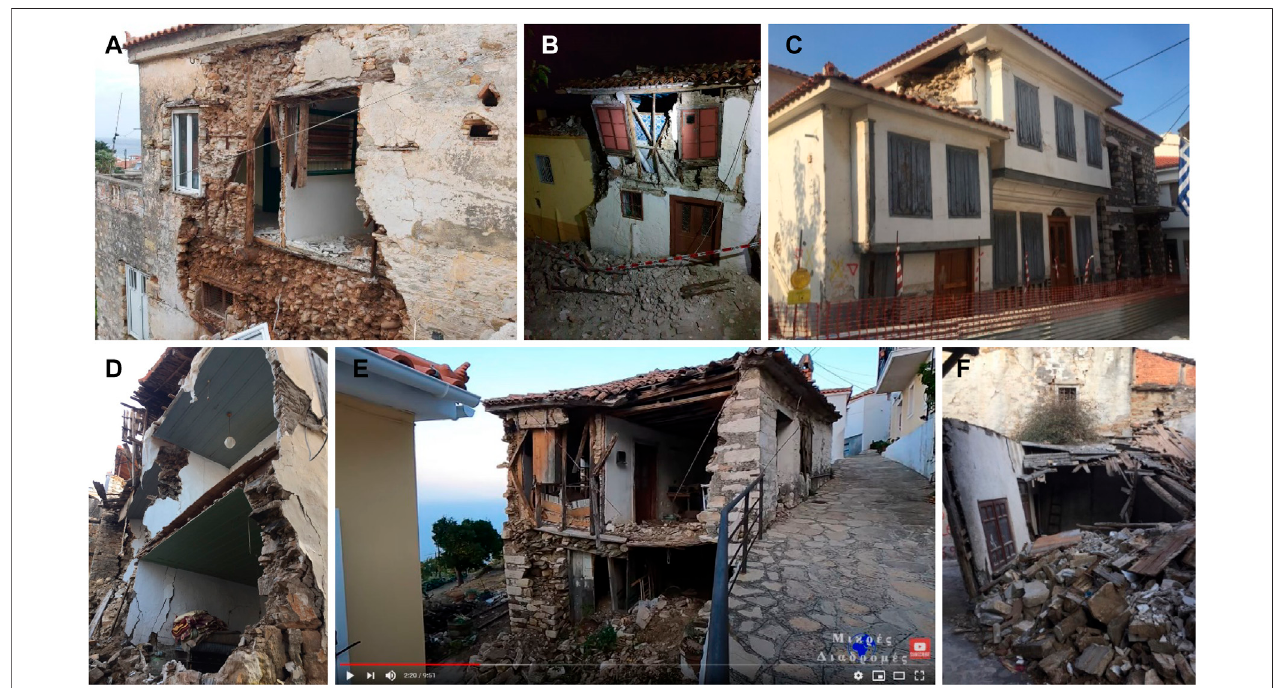
FIGURE 2 | Examples of timber-masonry structures which suffered from failure of masonry: (A – C) out of plane in fi ll failure of masonry in the upper fl oors, (D,E) failureofmasonryground fl oorandtimberframesabove (F) totalcollapseinducedbythefailureofthemasonryground fl oor[ (B,E) fromMikresDiadromesSamou,2020] [DG3-DG5] (all in Samos,